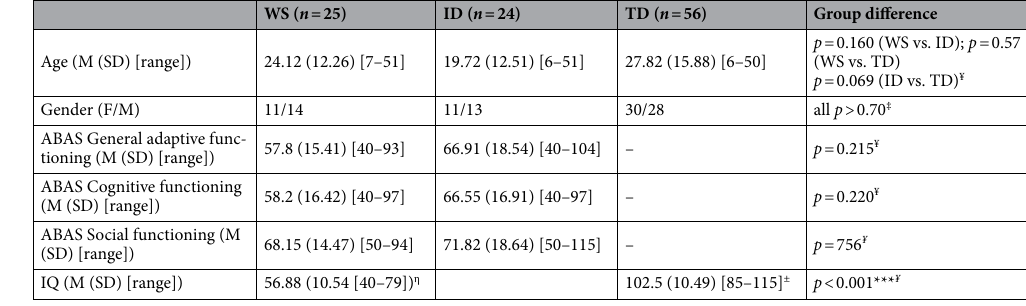
Table 1. Demographic characteristics. ¥ Mann–Whitney U; ‡ Chi-square test; ± estimated with Vocabulary subtest from the Wechsler Intelligence Scale for Adults, 4th Edition (WAIS-IV). Based on n = 19; ± based on WAIS-IV ( n = 13) or the Wechsler Intelligence Scale for Children, 5th Edition (WISC-5, n =